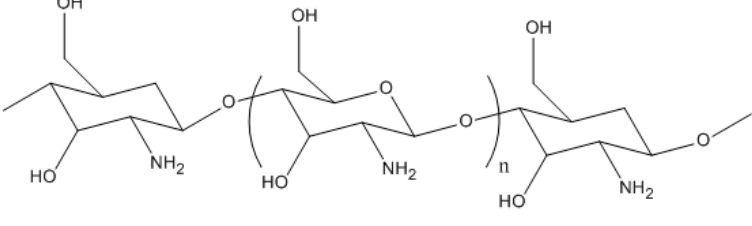
Figure 1. Chemical structure of chitosan.